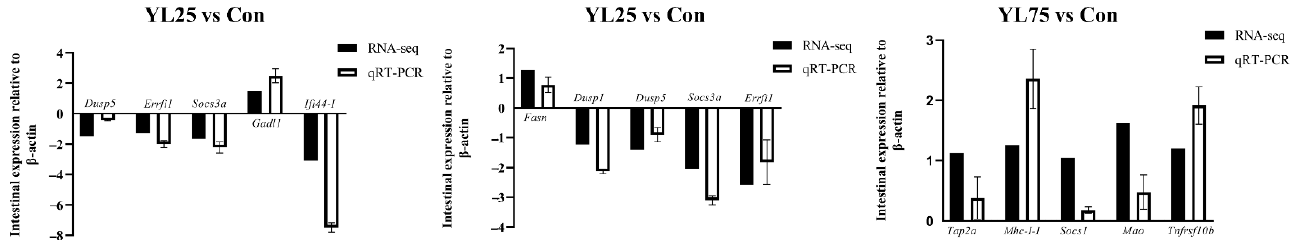
Figure 7. Gene relative expression in response to different dietary YL treatments as detected by qRT-PCR. Data were shown as means ± SD (standard deviation). The relative expression values were adjusted to the β -actin gene. Con was the control diet. In the other three diets, 25%, 50%, 75% of the fish meal was replaced with YL. The diets were named YL25, YL50, and YL75, respectively.